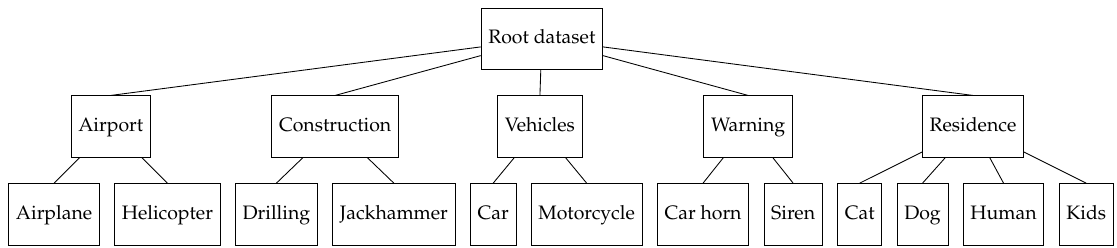
Figure 9. Detailed hierarchical dataset for the cascade approach.